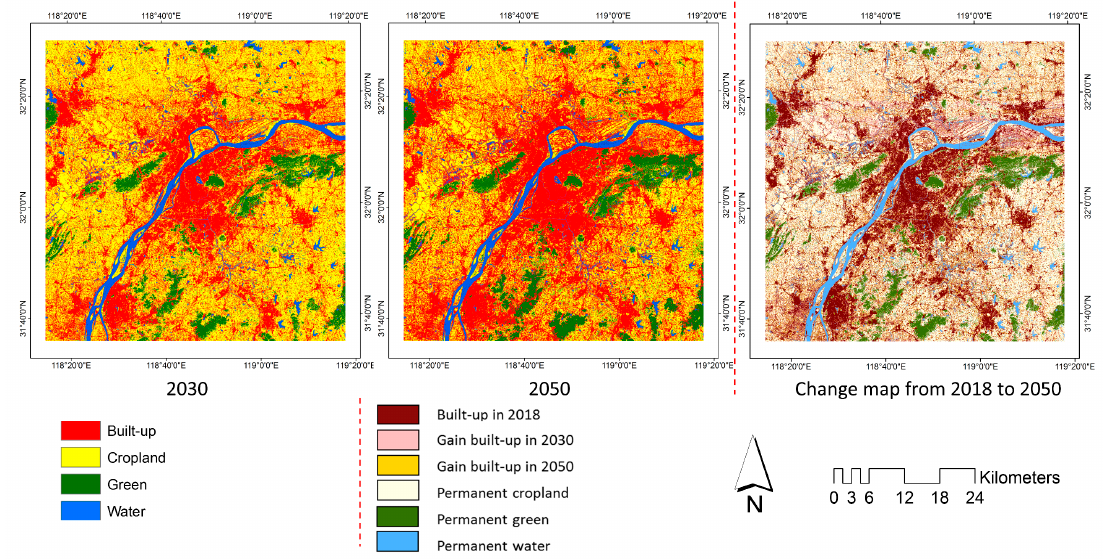
Figure 8. LULC distribution of Nanjing in 2030 and 2050, and the change map from 2018 to 2050.